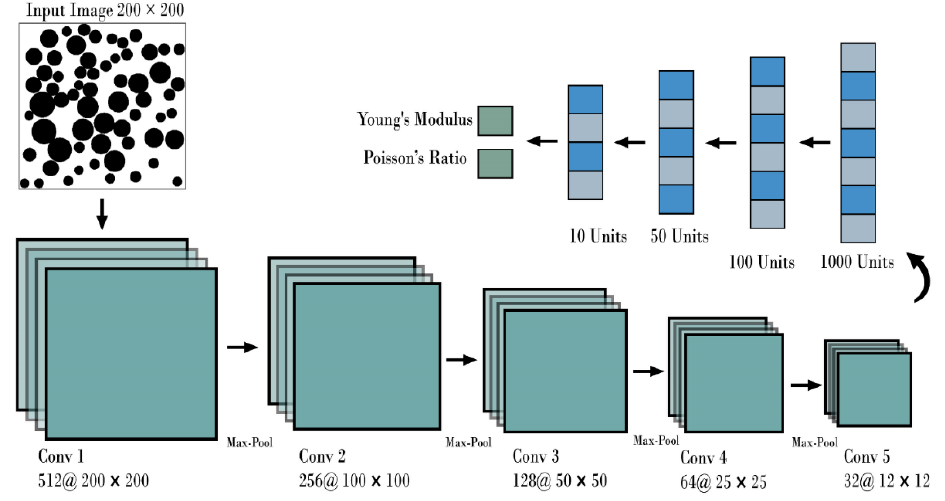
Figure 2. The CNN regression schematic for predicting Young ’ s modulus and Poisson ’ s ratio of BG-COL.